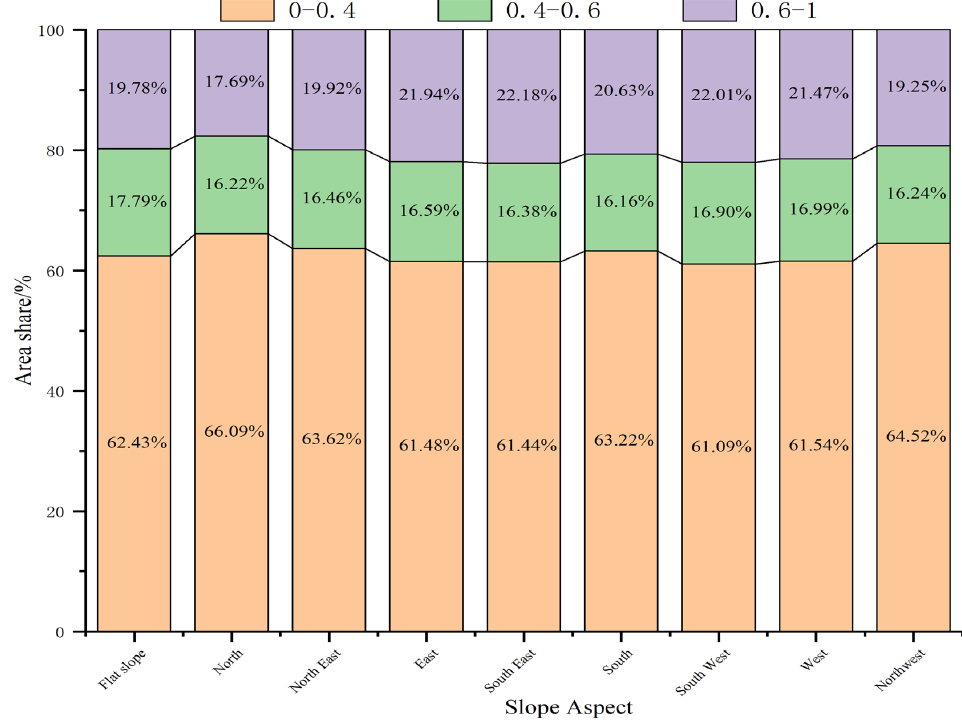
Figure 8. Percentage of FVC in different slope directions in the Three North Protection Forest Project area.